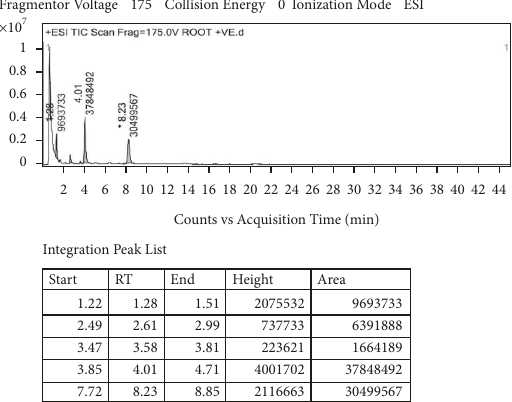
Figure 3: Mass spectral analysis of Astragalus candolleanus root extract by LC-MS-MS.